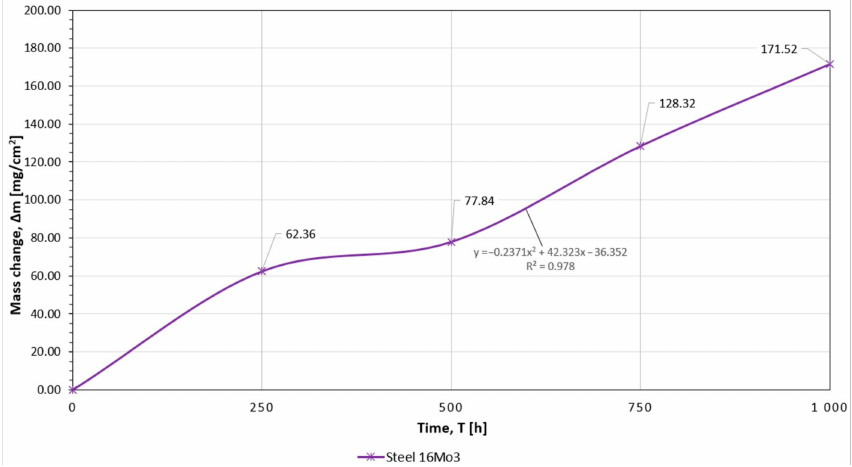
Figure 6. Graph of the unit weight change of 16Mo3 (1.5415) steel base material samples as a function of exposure to corrosive